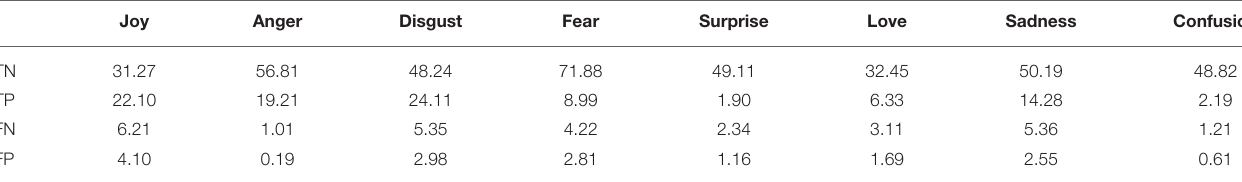
TABLE 5 | Calculation of the percentage of TN, FP, FN, and TP from the confusion matrix.